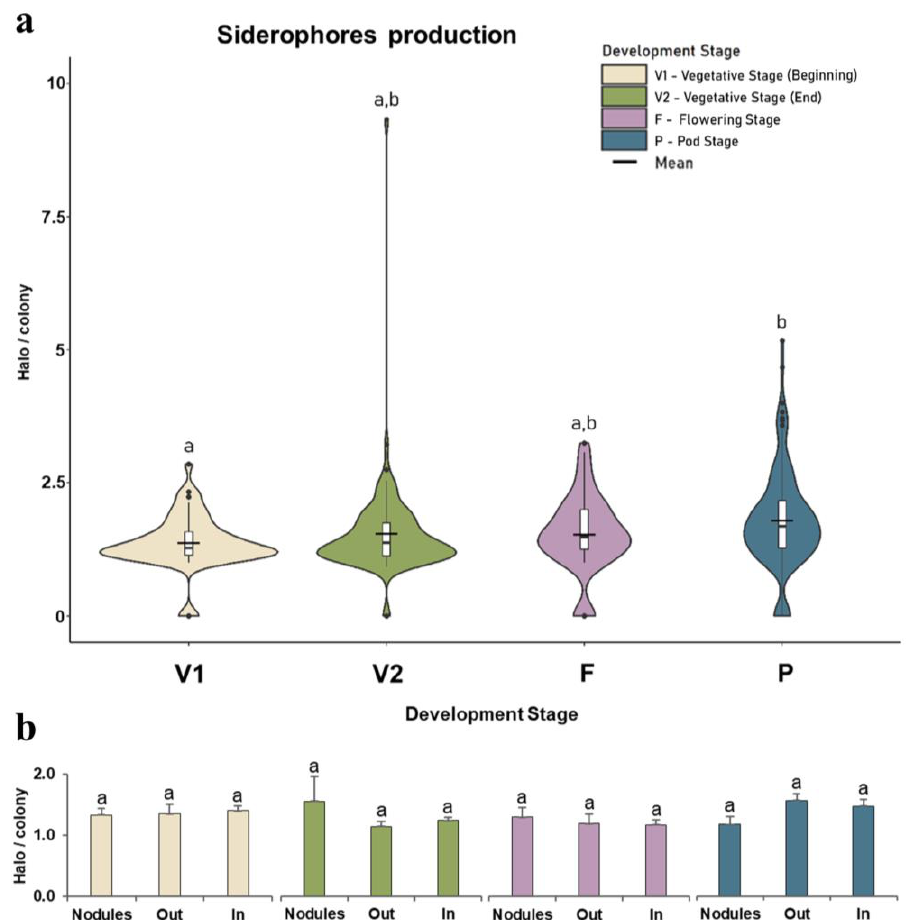
Figure 4. Bacterial ability to produce siderophores. ( a ) Violin plot representation of the overall siderophore production ability of bacteria isolated at each plant growth stage (beginning of the vegetative stage, V1; end of the vegetative stage, V2; flowering stage, F; and pod stage, P). Outlier values (back dots) and average (black line) are marked. ( b ) Bar chart representation of the average siderophore production in each root compartment (rhizoplane outside the root—out, inside the root—in, and in nodules—nodules). Sixty strains at stage V1 and 108 strains from the P stage were used to construct violin plots. Chart bar values are the means ± standard deviation of siderophore production from 15 strains belonging to the V1 stage from Out and Nodules (root compartments) to 49 strains from the P stage in Out (root compartment). Significant differences ( p < 0.05) among development stages (violin plots) and root compartments (bar charts) were represented by different lowercase letters (a and